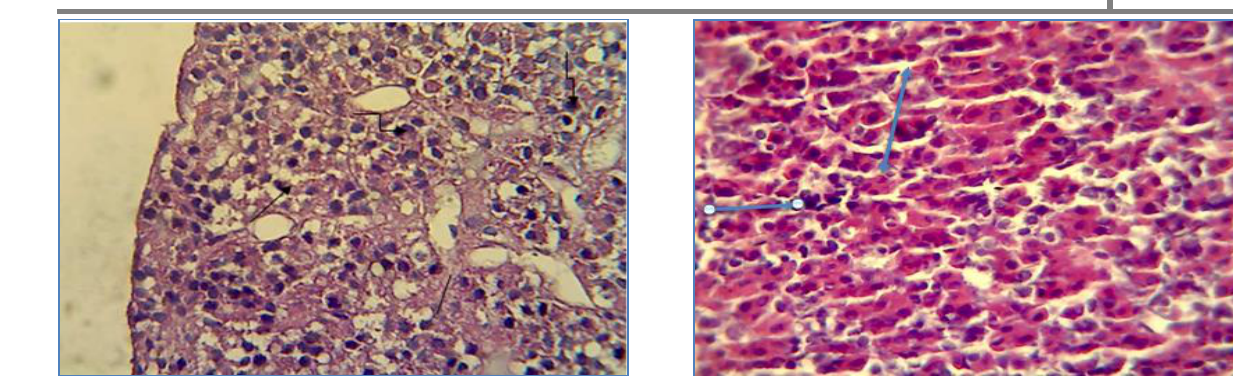
Figure, 7: Section in pituitary gland of animal treated with Eruca Sativa (G3) shows normal cellular composition of the pars distalis, chromophobes cells ( ) and chromophils cells ( ) (H and E stain 40X)